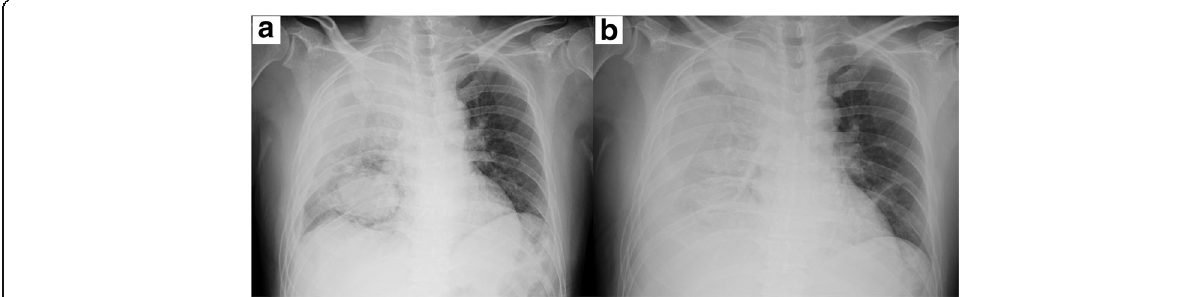
Fig. 1 Chest X-ray showing reduced radiolucency of the right lung field and an opacity in the right lower lung field ( a ). The following day, the chest X-ray findings deteriorated further ( b )